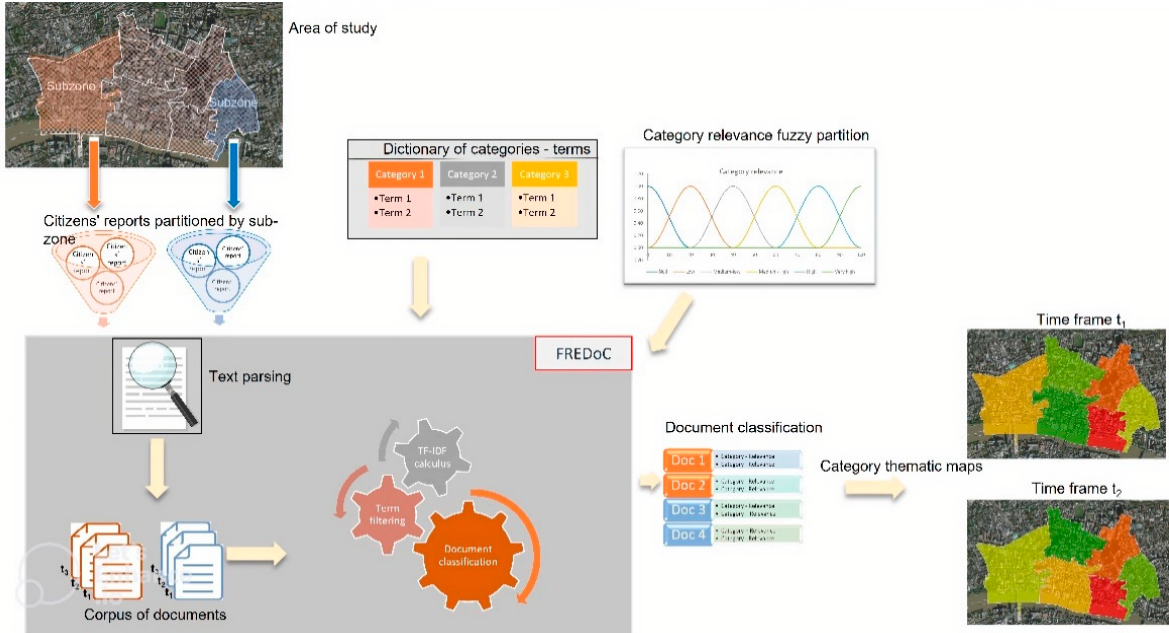
Figure 3. Schema of the proposed GIS-based framework.